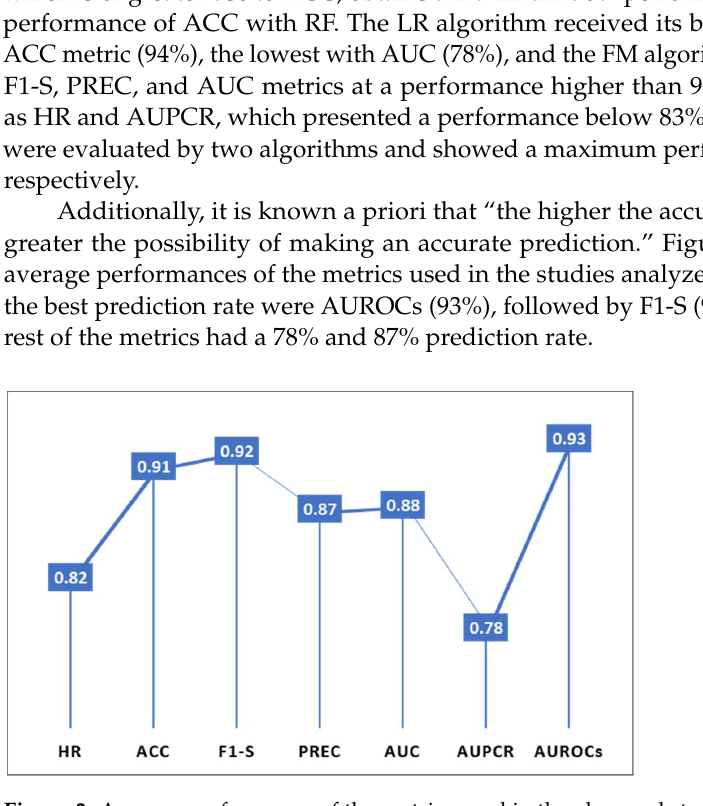
Table 6. Algorithm performance based on the evaluation of the best-performing metrics within the observed studies.